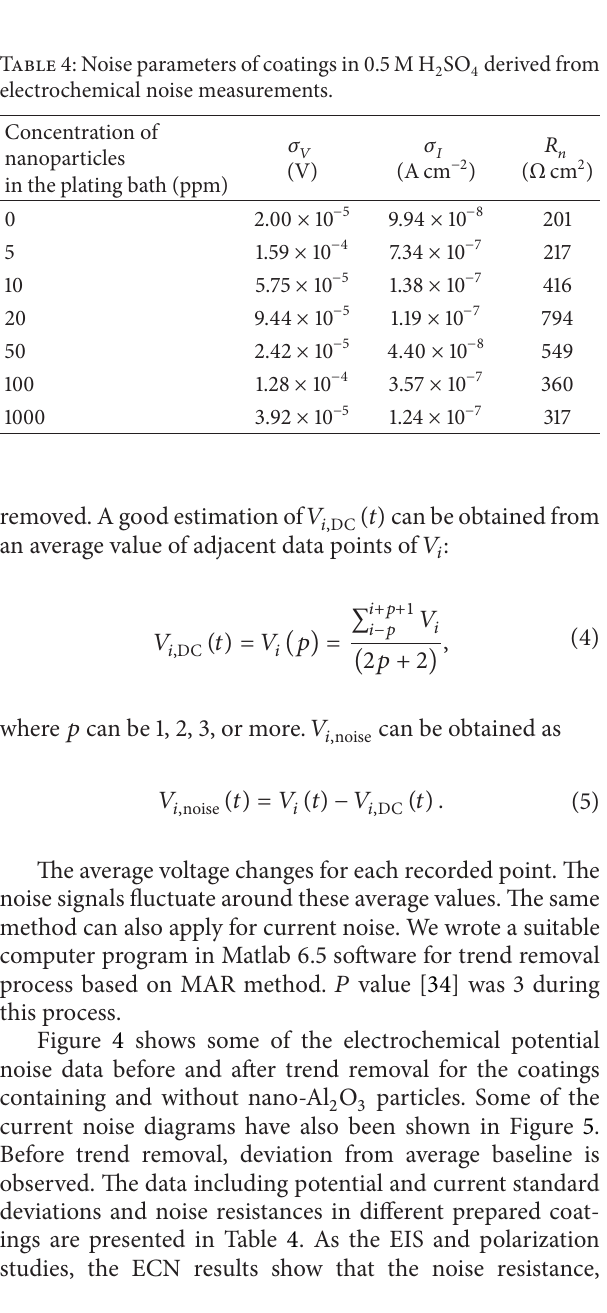
SO derived from 2 4